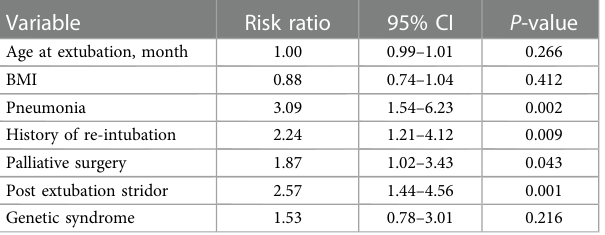
TABLE 3 Results from the multivariable log-binomial regression with generalized estimating equations exploring predictive factors associated with extubation